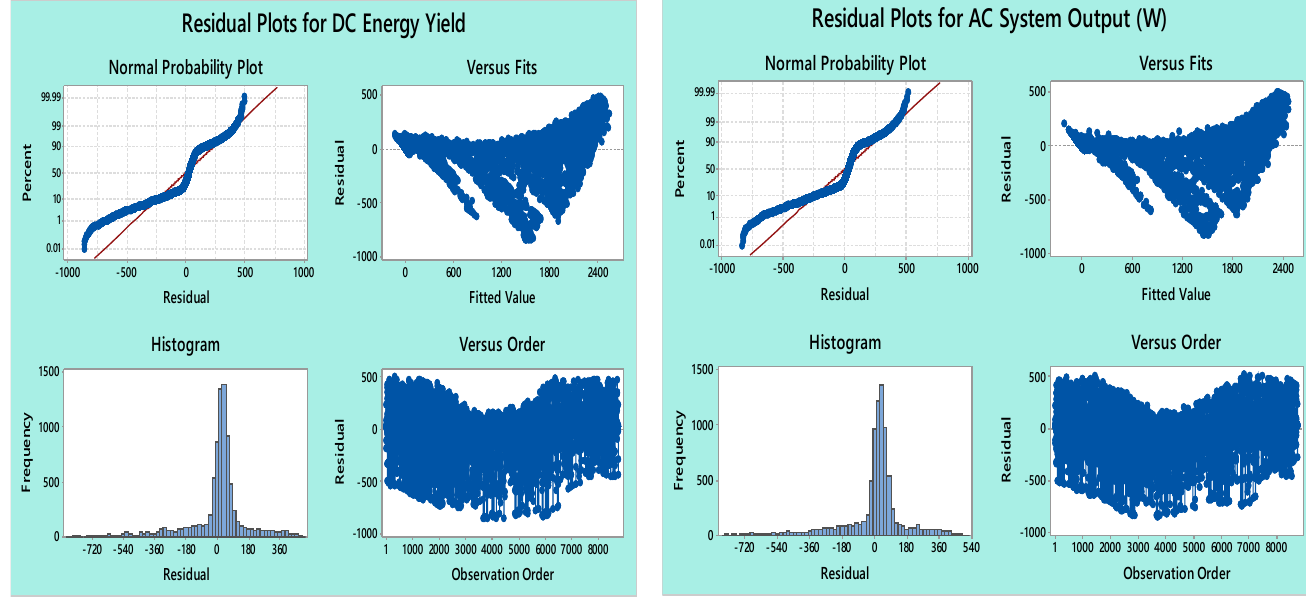
Figure 3. Residual Plots AC Power (a) Normal Probability Plot (b) Residual Vs Fitted Value (c) Histogram Plot (d) Residuals versus the Order of the Trial